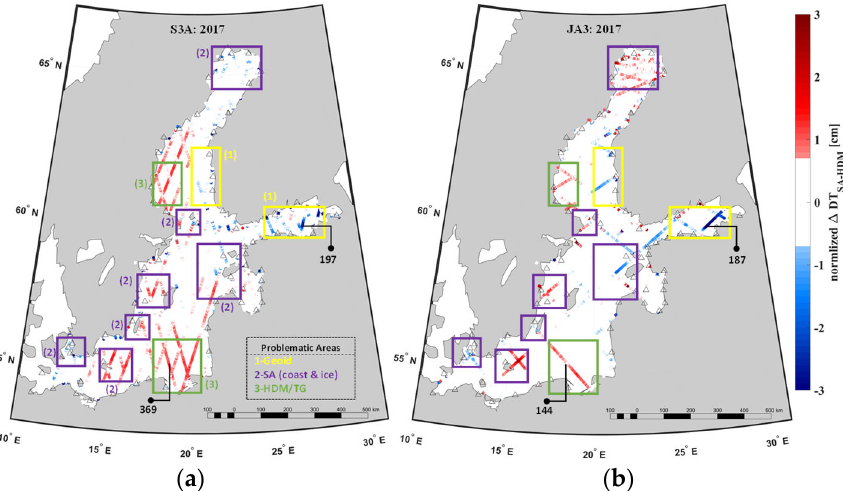
Figure 14. Problematic DT determination areas over the Baltic Sea. ( a ) Normalized mean of Δ𝐷𝑇 SA − HDM ( MEAN SA − HDM ) of S3A data ( a ) and JA3 data ( b ) over the Baltic Sea in 2017. The problematic areas are enclosed by colored rectangles (and numbers) to classify the possible reasons. Geoid: yellow, SA: purple, and HDM or TG: green. Four selected passes (two passes for S3A and two passes for JA3) are speci fi ed to illustrate the possible reasons (cf. Figure 12).